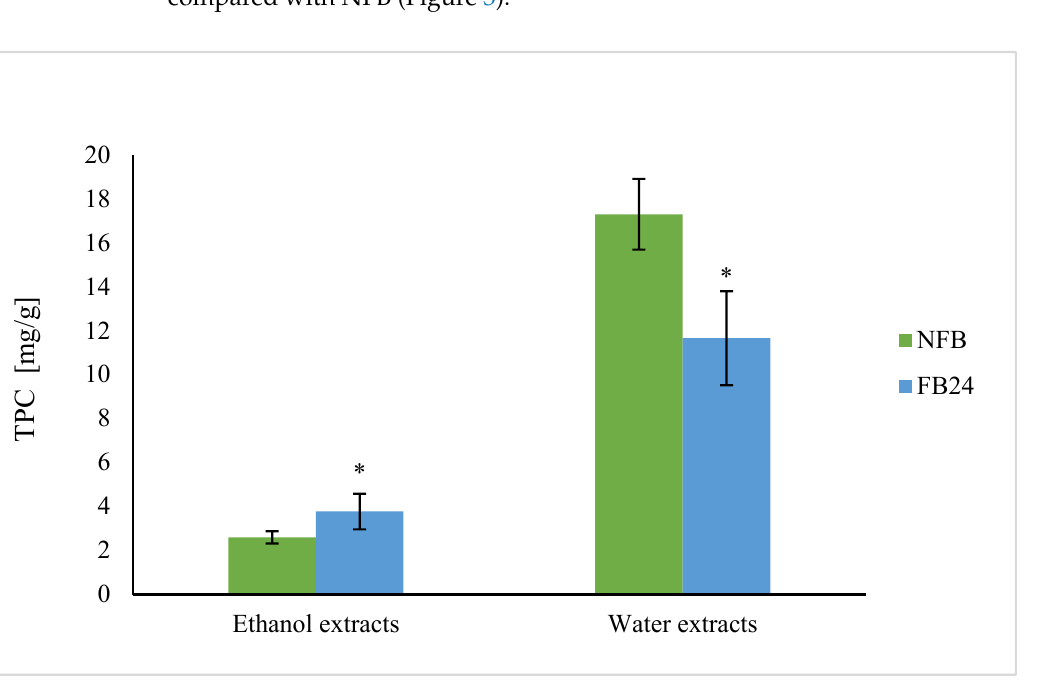
Legend: Statistically significantly different values between FB and NFB are written in bold ( p < 0.05).